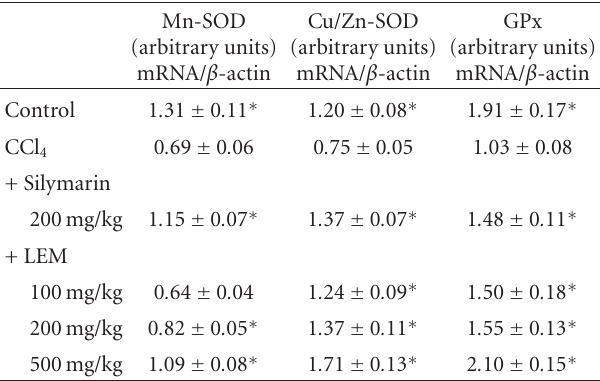
Table 1: The quantification of mRNA levels for Mn-SOD, Cu/Zn- SOD, GPx, or β -actin in liver isolated from CCl 4 -induced rats receiving treatment with silymarin or LEM three times daily for 8 weeks. Quantification of mRNA levels using Mn-SOD/ β -actin, Cu/Zn-SOD/ β -actin, and GPx/ β -actin was expressed as mean with standard error (SE) ( n = 4 per group) in each group. ∗ P < 0 . 05 compared with CCl 4 -induced group receiving vehicle.